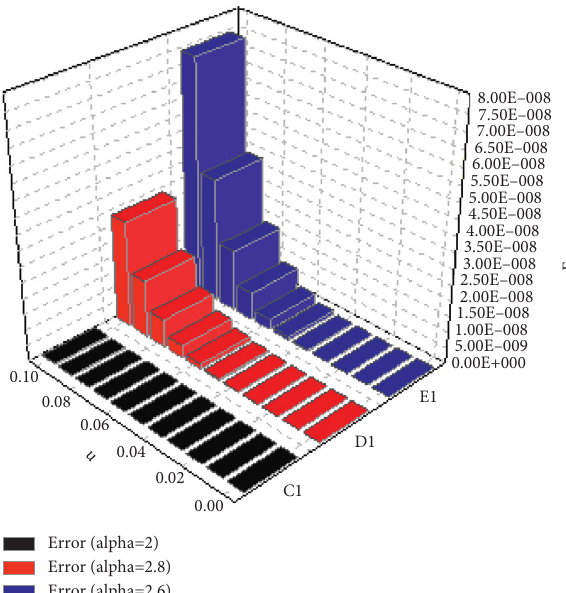
Figure 13: The graph of absolute error at various fractional orders for problem